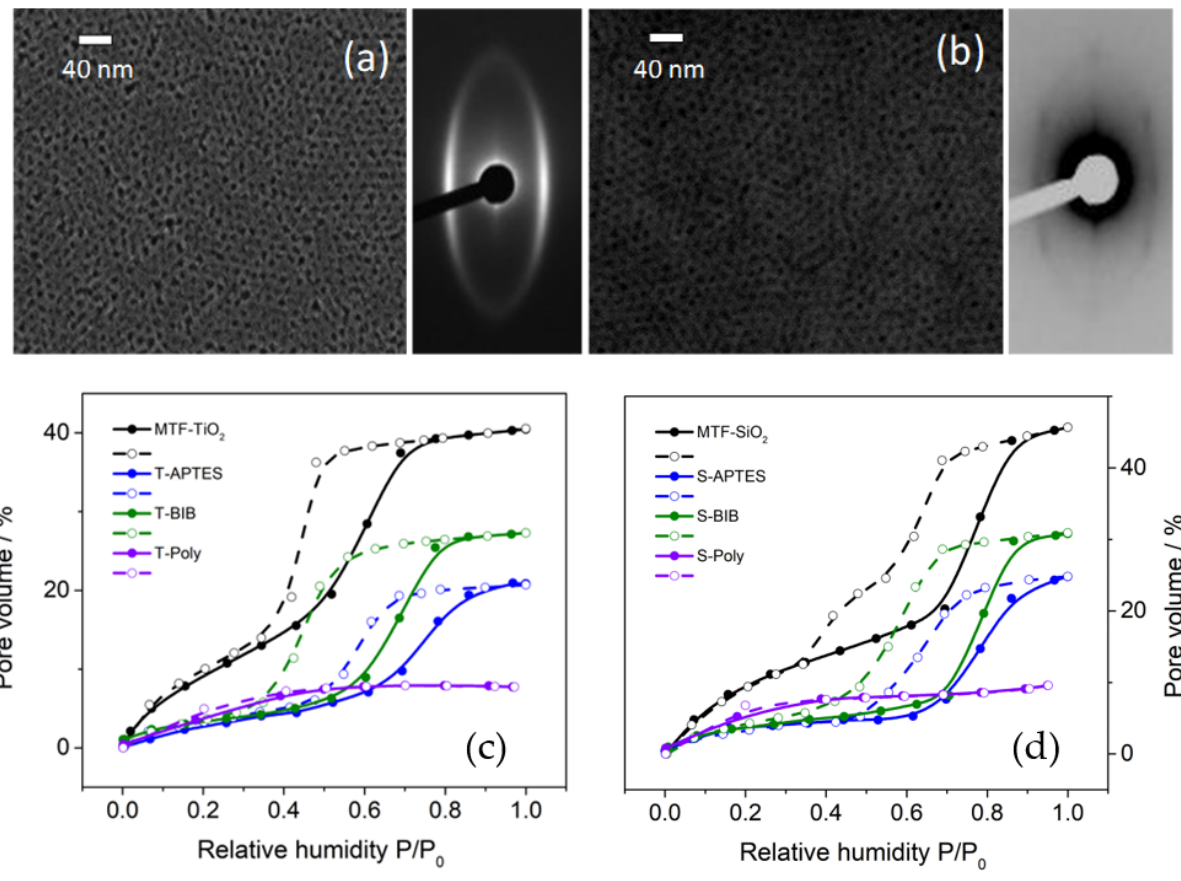
Figure 2. Typical SEM micrographs and SAXs patterns of calcined samples of ( a ) MTF-TiO2 and ( b ) MTF-SiO 2 . Pore volume measured by EEP for MTF-TiO 2 ( c ) and SiO 2 ( d ) before and after being functionalized with APTES (T-APTES and S-APTES), APTES-BIB (T-BIB and S-BIB) and APTES-BIB- ATRP (T-Poly and